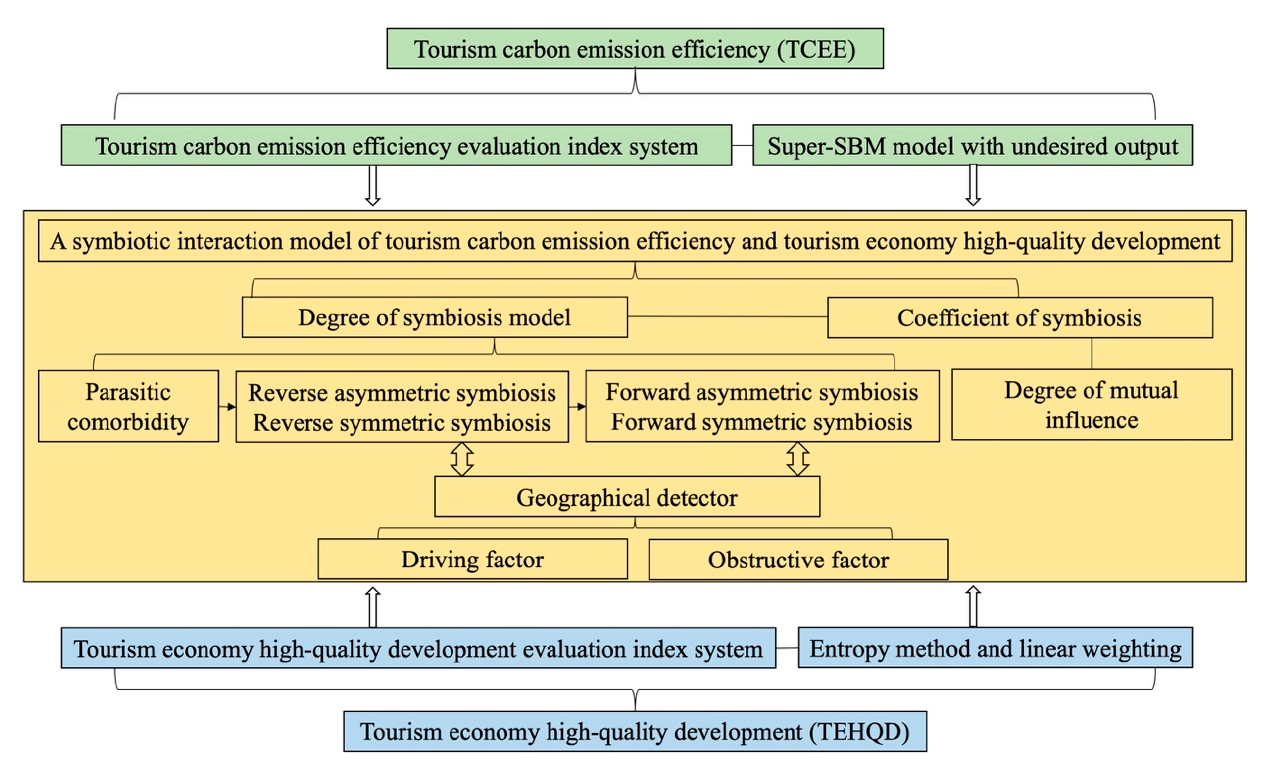
Figure 1. Analysis framework of the symbiotic interaction model between tourism’s carbon emission efficiency (TCEE) and the tourism economy’s high-quality development (TEHQD).